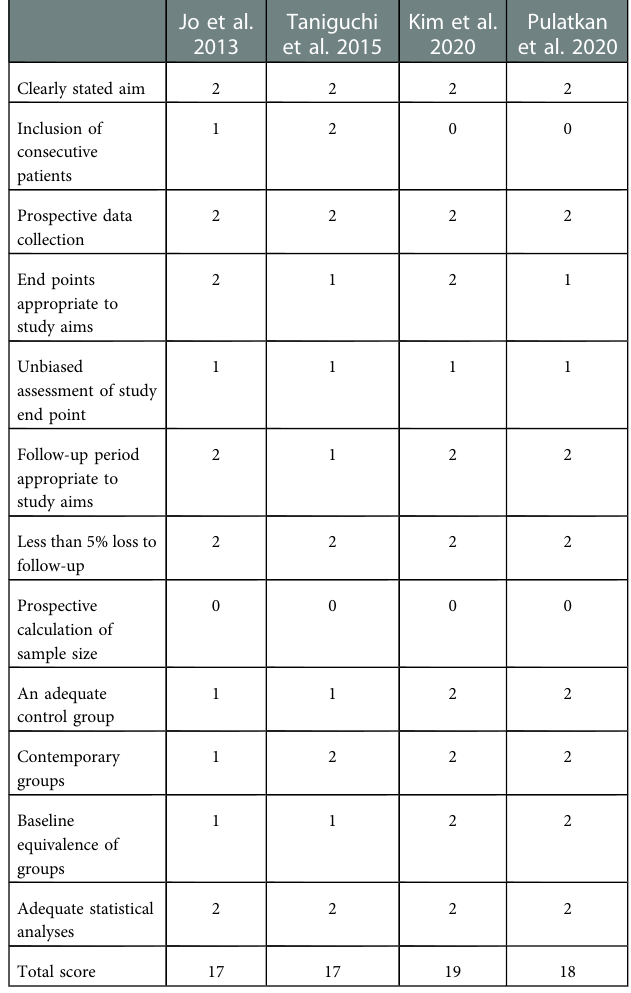
TABLE 3 Risk of bias assessment for non-RCTs with the MINORS score.